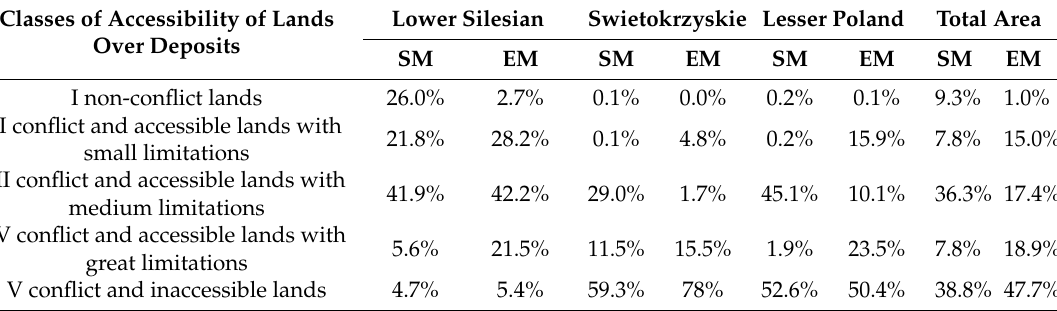
Figure 3. The result of the multi-criteria analysis for the environmental ( b , d ) and the social ( a , c ) model. Table 4. Classes of accessibility of lands over the undeveloped dimension and crushed stone deposits (for selected